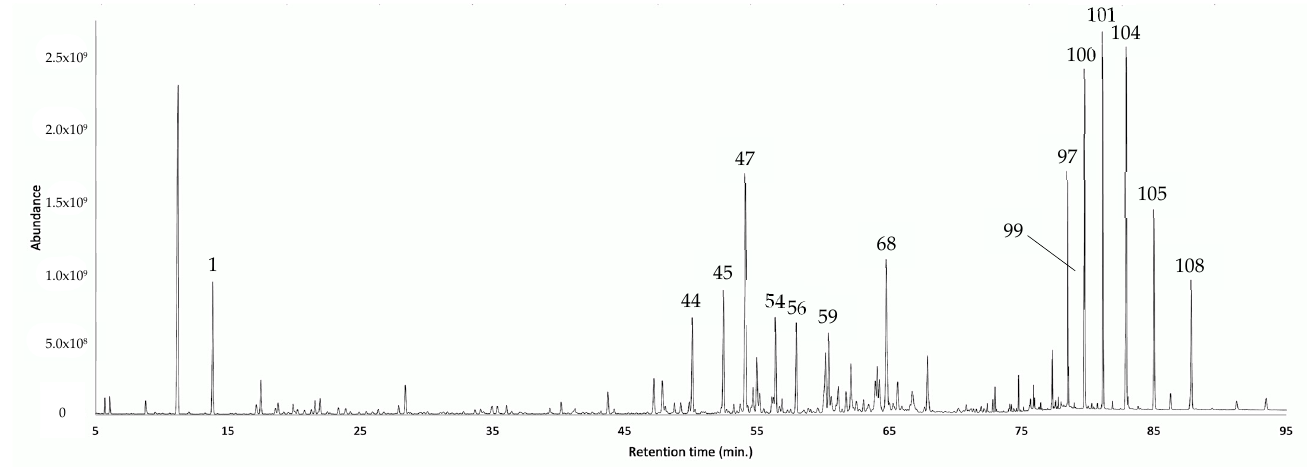
Figure 2. GC–MS chromatogram of the EO from the leaves of G. rugulosa in a 5% phenyl- methylpolysiloxane-based column. The main components are represented with the respective peak number, according to Table 1.